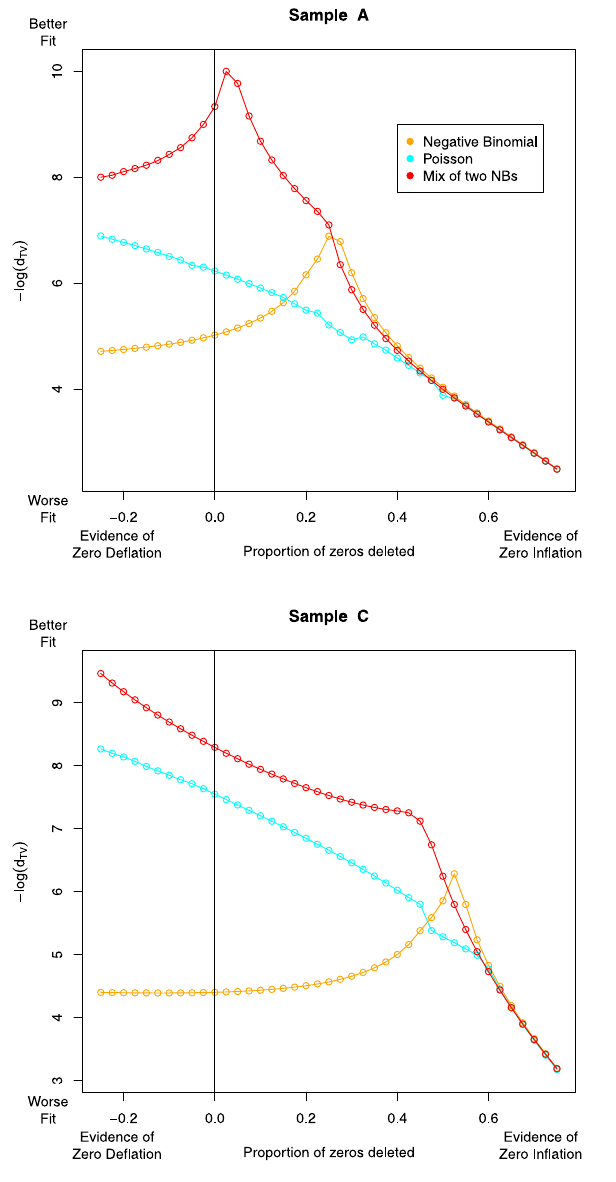
FIGURE 7 | The effect of zero removal on the model fit. Each Subfigure represents an individual sample. A proportion of zeros are removed (or added), and after refitting each model, we reassess model fit with the Total Variation distance d TV , plotted as − log ( d TV ) on the Y -axis against zero proportion on the X -axis. For severely zero-inflated data, deleting zeros should improve model fit, so we expect to see a “peak” somewhere to the right of the black vertical